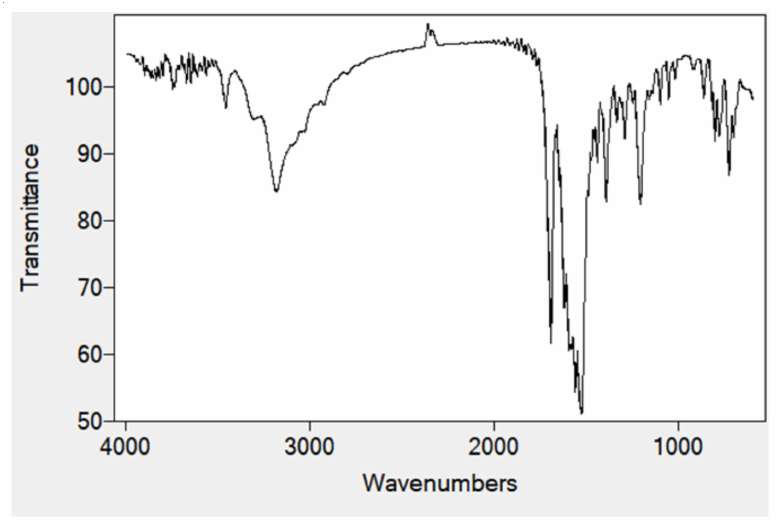
Figure 5. FTIR spectrum of compound 2